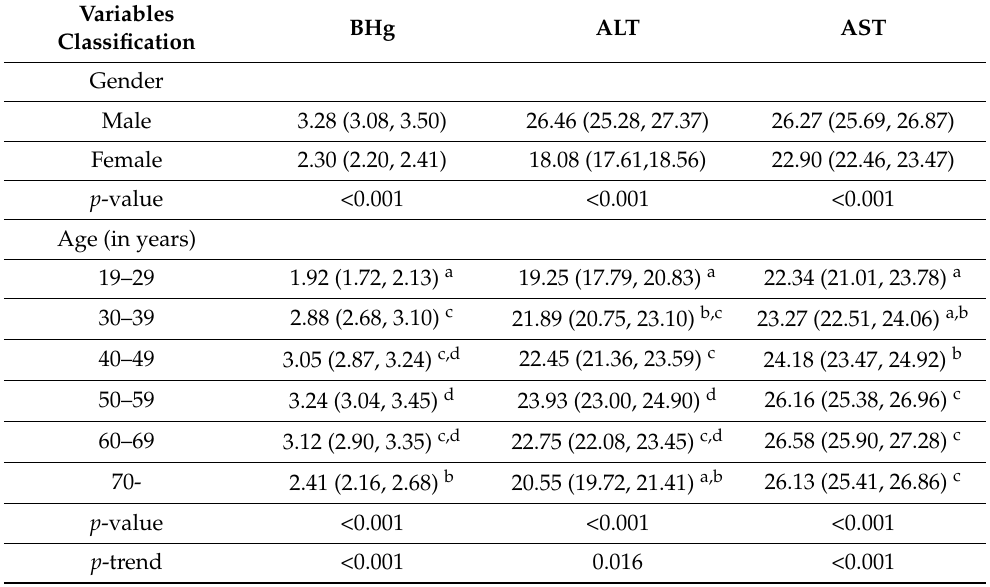
Table 2. Mean and 95% confidence interval of blood mercury ( µ g/L), serum AST (IU/L) and ALT (IU/L) by characteristics of study population, KoNEHs